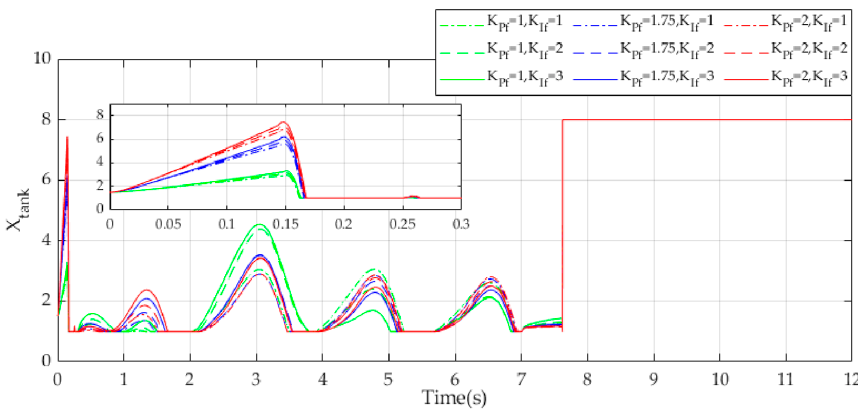
Figure 12. Response of the energy variable under different force control gains.